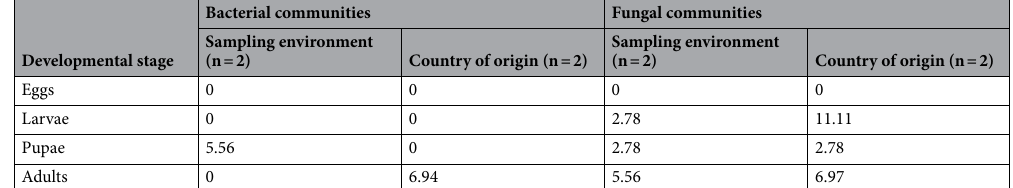
Table 2. Out of basket errors (%) after assigning samples to two categories according to sampling environment (farm/lab) or country of origin (Netherlands/Spain) with random forest classification.